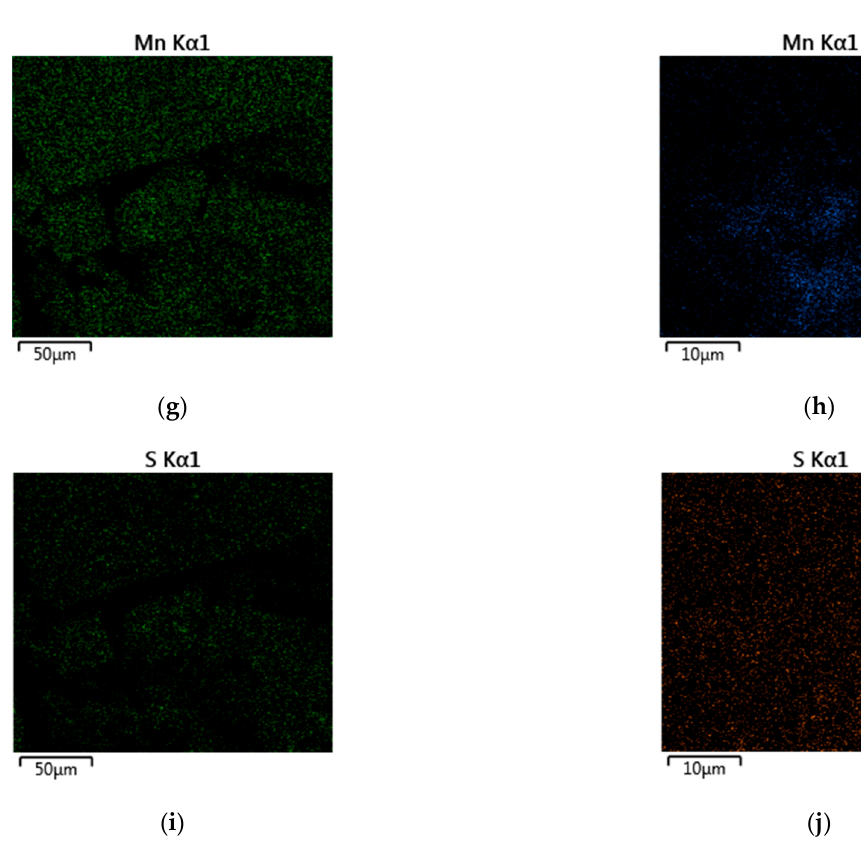
Figure 6. EDS mapping of ( a ) Lig-MnO 2 and ( b ) AC/Lig/MnO 2 . For Lig-MnO 2 , EDS mapping for C ( c ), O ( e ), Mn ( g ), and S ( i ) are shown. For AC/Lig/MnO 2 , EDS mapping for C ( d ), O ( f ), Mn ( h ), and S ( j ) are also shown.